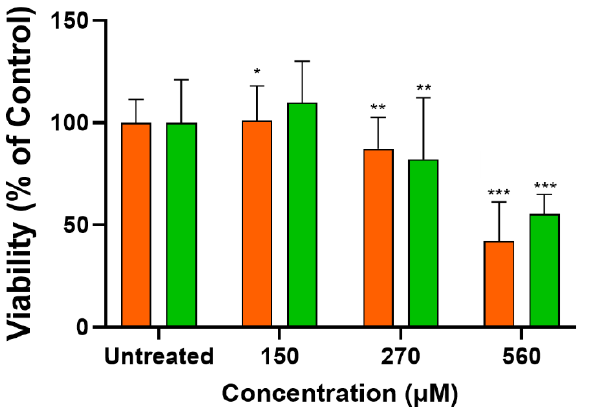
Figure 8. RPTEC culture response to different concentrations of the nephrotoxic antibiotic colistin under static and dynamic conditions: Viability of RPTEC cultures maintained for 4 days and subsequently exposed for 2 days to three concentrations of the nephrotoxic antibiotic colistin was measured by ATP assay. Data are shown as percentage of control and represented as mean ± SD and compared to the corresponding untreated cells (n = 2 biological repeats in triplicate technical repeats; * p ≤ 0.05; ** p ≤ 0.01; *** p ≤ 0.001).